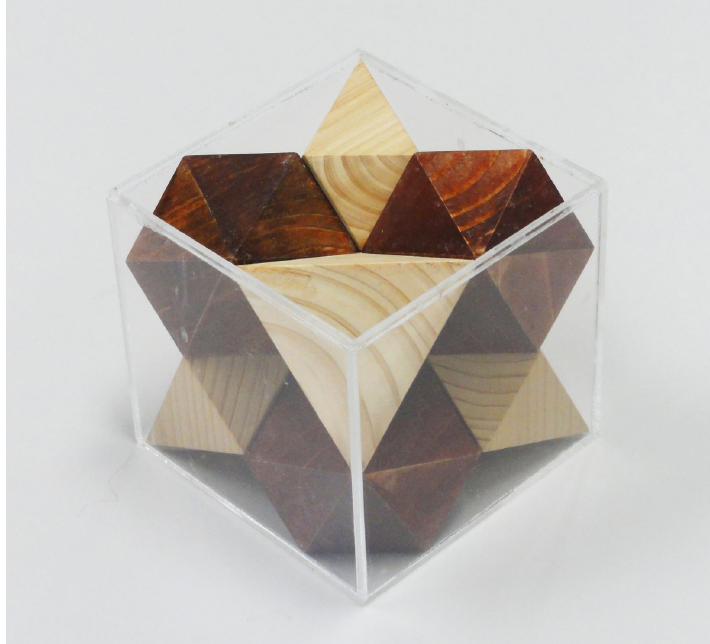
Figure 9. The solution looked at from a